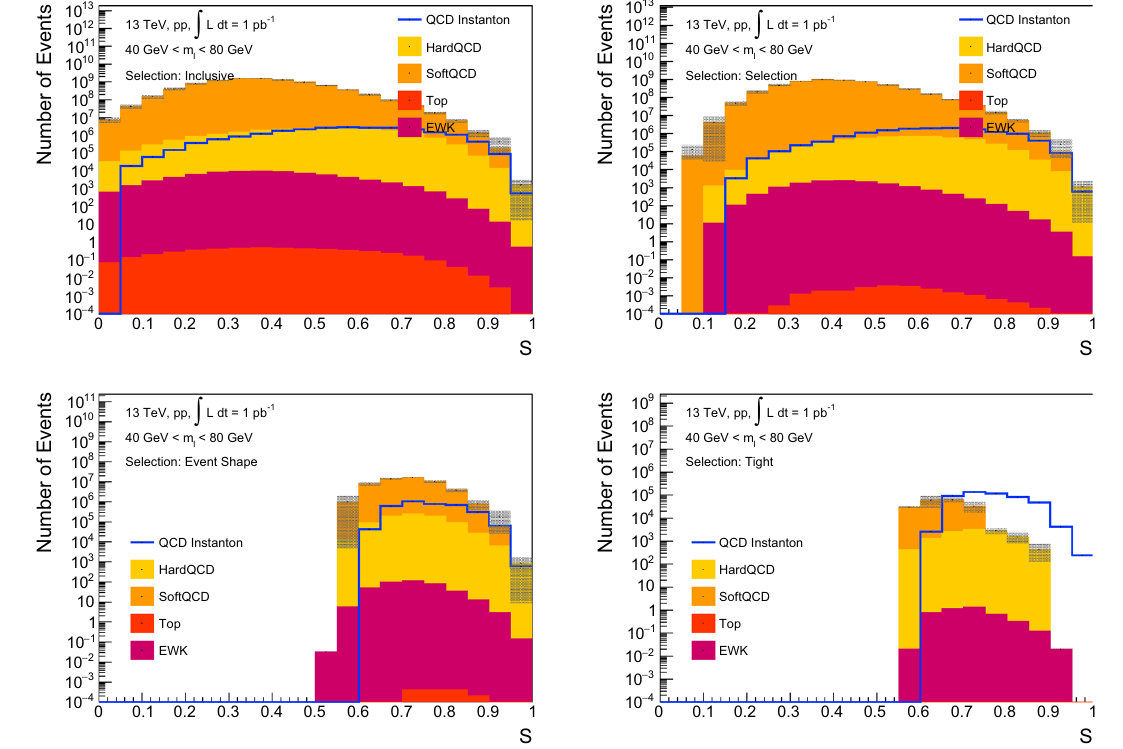
Fig. 13 Predicted distributions of the event sphericity for various pro- cesses,weightedbytheirpredictedcrosssectionsforanintegratedlumi- (cid:8) nosity of L = 1pb − 1 for an inclusive selection (upper left), the nom- inal selection (upper right), the event-shape based selection (lower left)